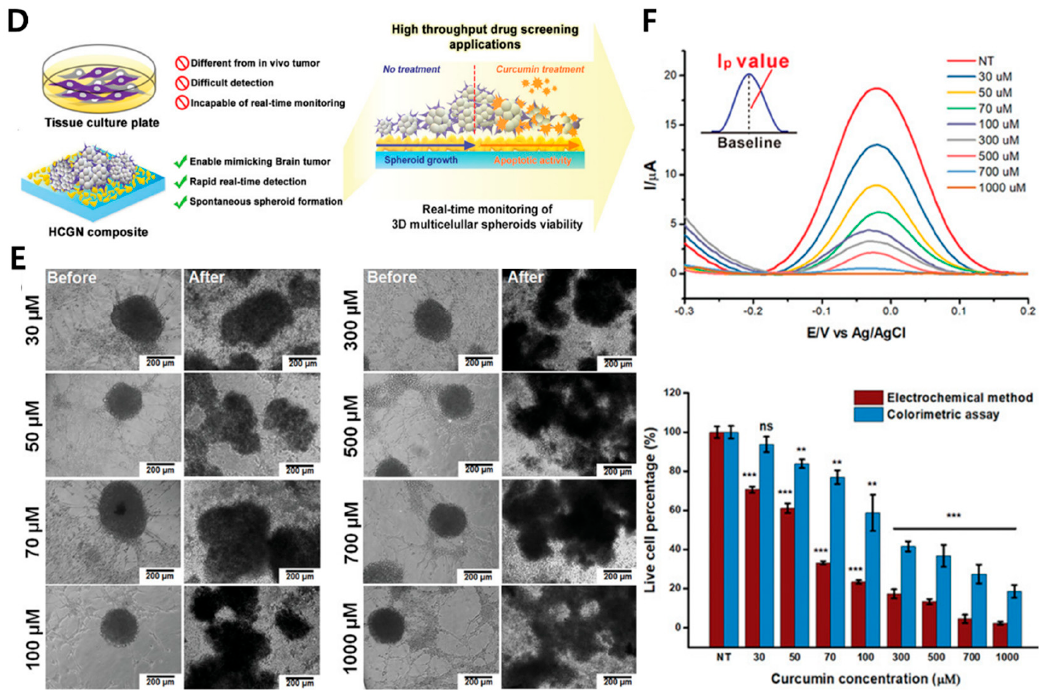
Figure 5. ( A ) Construction of a 3D microgroove impedance sensor (MGIS) and a real image of the complete sensor with 3D cell culturing. ( B ) Real-time monitoring of the anticancer drug effects on 2D/3D lung cancer models. ( C ) Live–dead cell analyses of exposure to cisplatin at certain concentrations on day 7. ( D ) Schematic of a highly conductive gold nanostructure (HCGN) biosensor for the viability of 3D multicellular spheroids. ( E ) Microscopy images of 3D-cultured spheroids before/after treatment with curcumin at specific concentrations. ( F ) Electrochemical assessments of the toxicity of curcumin in 3D-cultured spheroids. Reprinted with permission from [121].